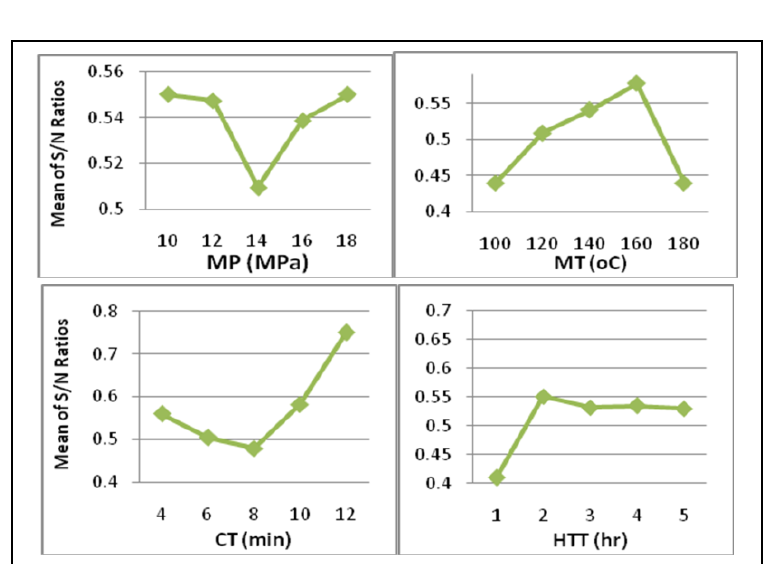
Figure 3: Main effect plots for seashell based